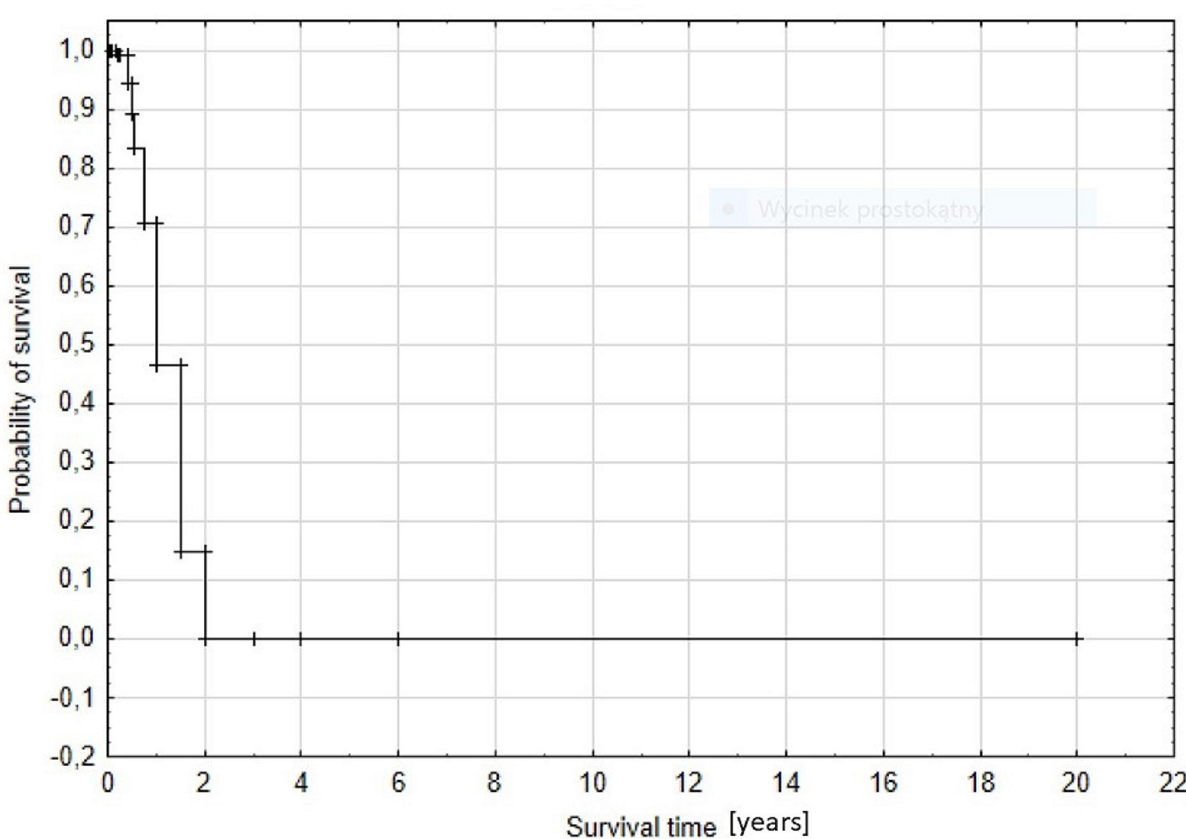
Fig 1. Survival analysis from Cox proportional model, showing the probability of survival depending on